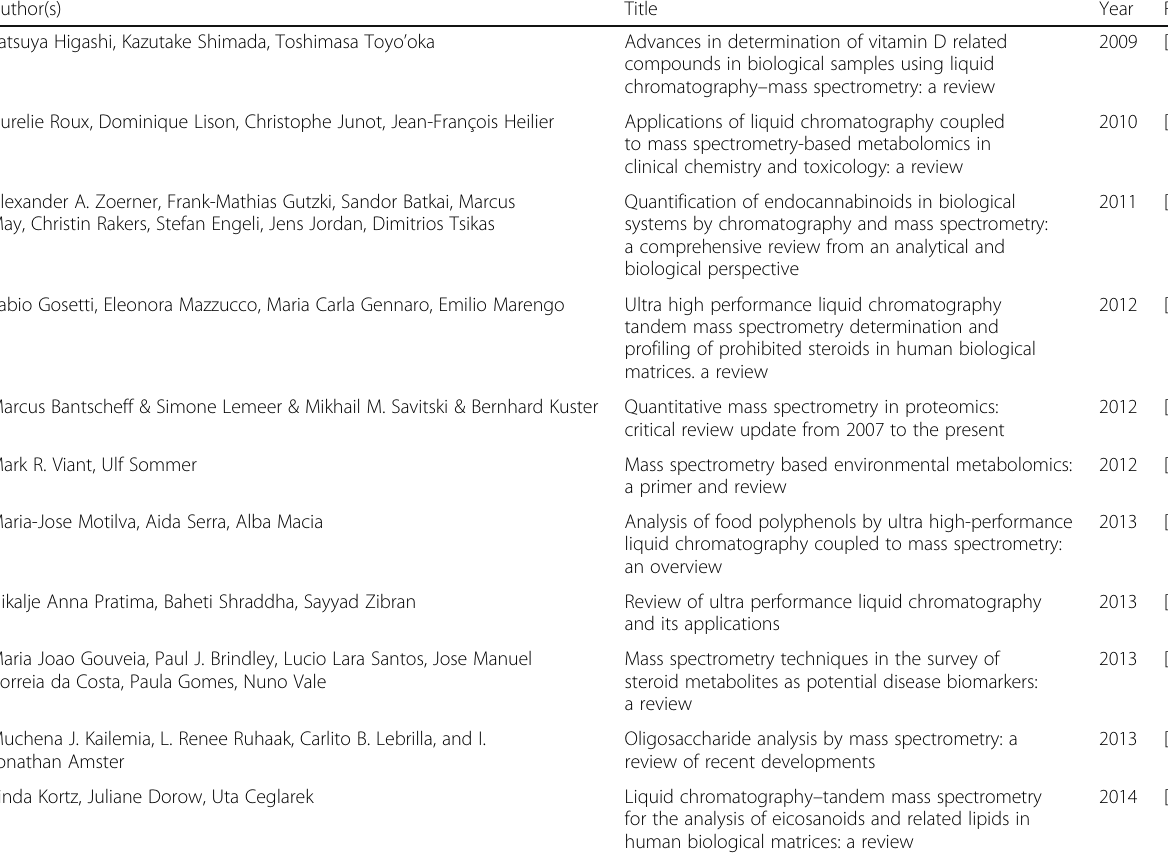
Table 2 Present perspective on UHPLC-MS/MS methods